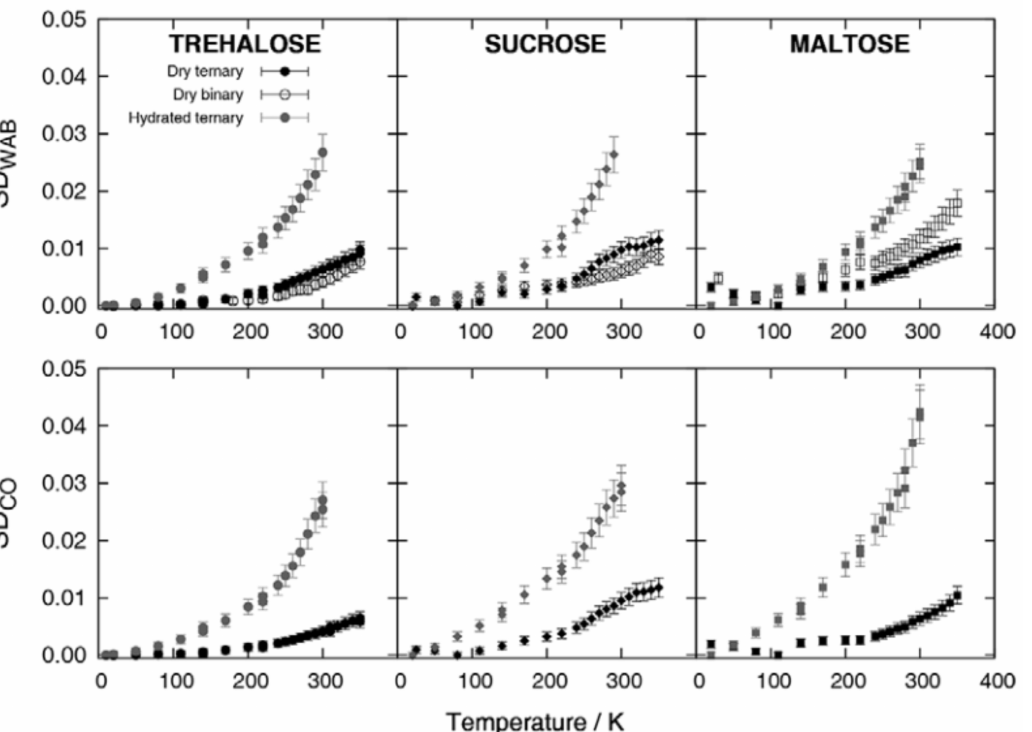
Figure 6. Functional distance of the spectra (Spectra Distance, SD) as a function of temperature, from the spectrum measured at the lowest temperature investigated. Remarkably, in trehalose only, the SDWAB for binary samples has values comparable with dry ternary samples, a mark for a strong protein–matrix coupling. Reproduced without changes from Ref. [106], with permission from Springer Nature, Copyright 2013, license number